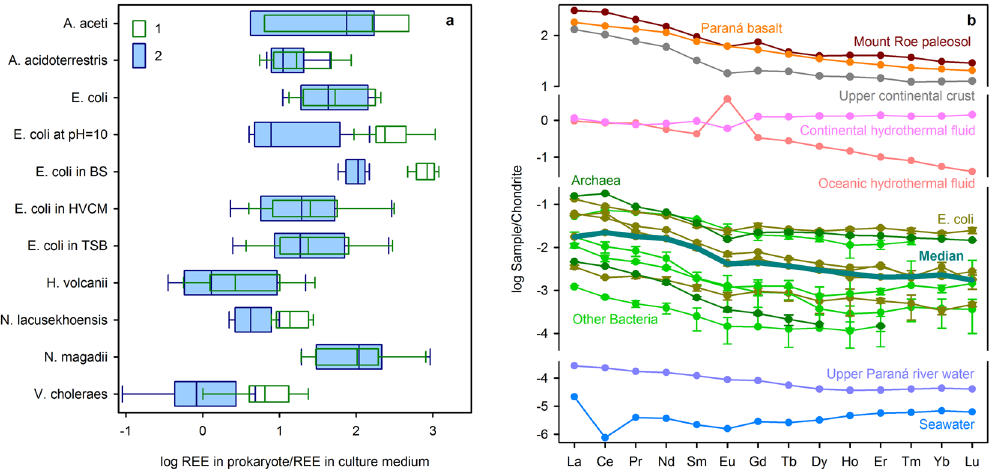
Figure 5. REE in prokaryotes versus ( a ) their contents in nutrient media (1-REE ratios for cells before and 2-after washing procedure) and ( b ) selected rocks and fluids. The C1 normalized plots are shown for Mount Roe basalt paleosol (MR#1 20 ), Paraná basalt, upper continental crust 41 , mean trends for continental and oceanic hydrothermal fluids 43 , Upper Paraná river water draining the Paraná basalts 75 and seawater 76 . The median (dark cyan) is plotted for archaea (dark green), E. coli (dark yellow) and other bacteria (light green). Uncertainties are 1 σ .